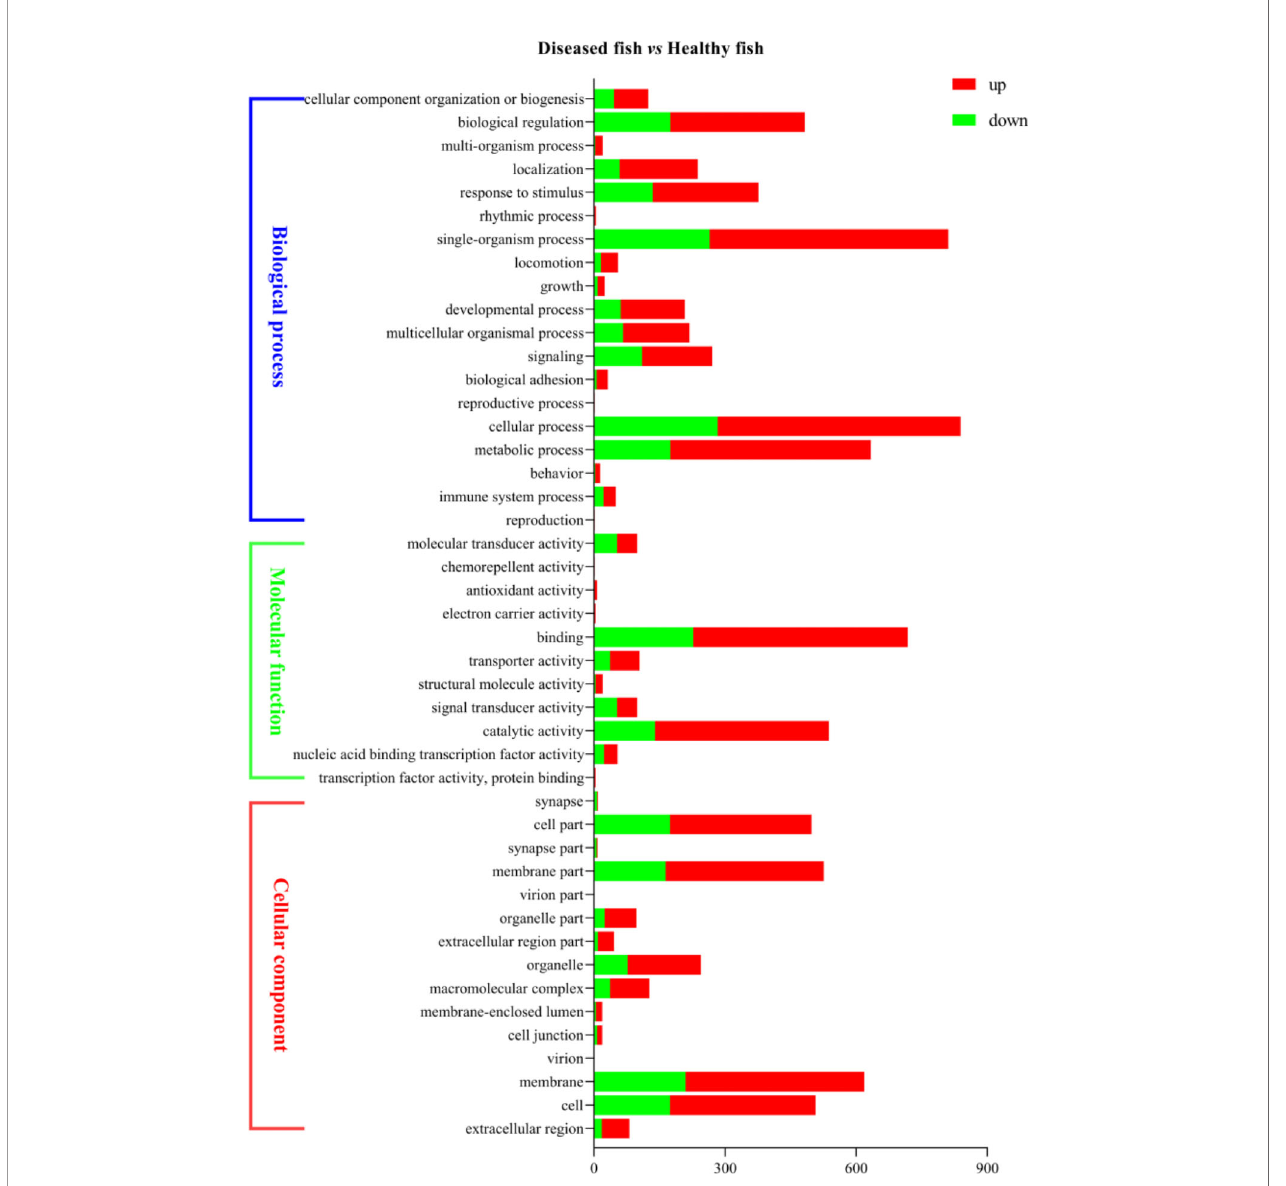
FIGURE 5 | Bar graph description of Gene Ontology (GO) enrichment of DEGs. The X-axis corresponds to the number of DEGs. The Y-axis represents various GO terms. The healthy group was used as the control group, and the green bar and red bar represent down- and up-regulated DEGs,